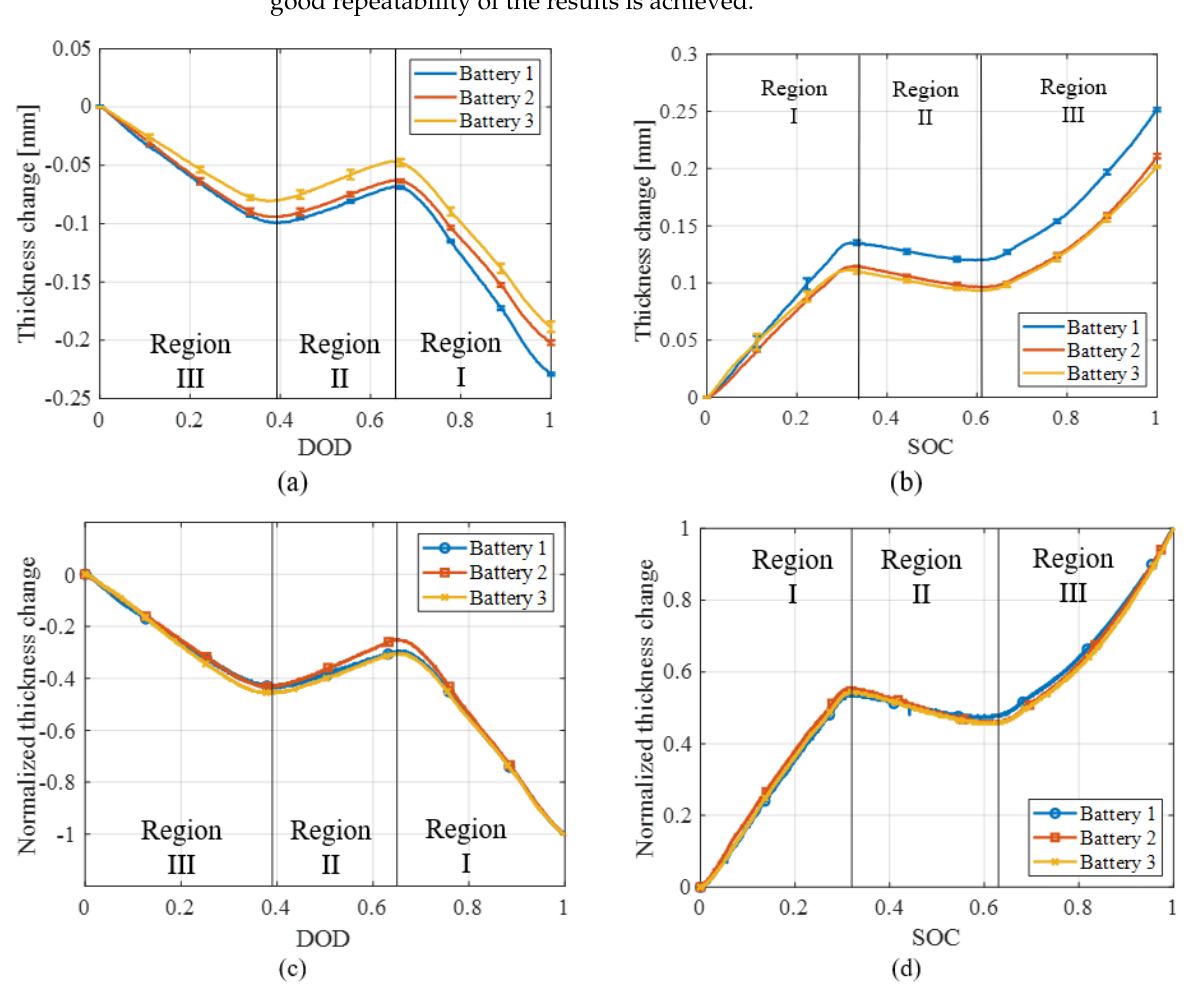
Figure 6. Thickness change during C/10 discharge ( a ) and charge ( b ) and its normalization ( c ) and ( d ), respectively. Solid lines refers to mean value and error bars identify maximum and minimum range of variation of the measurements in ( a ) and ( b